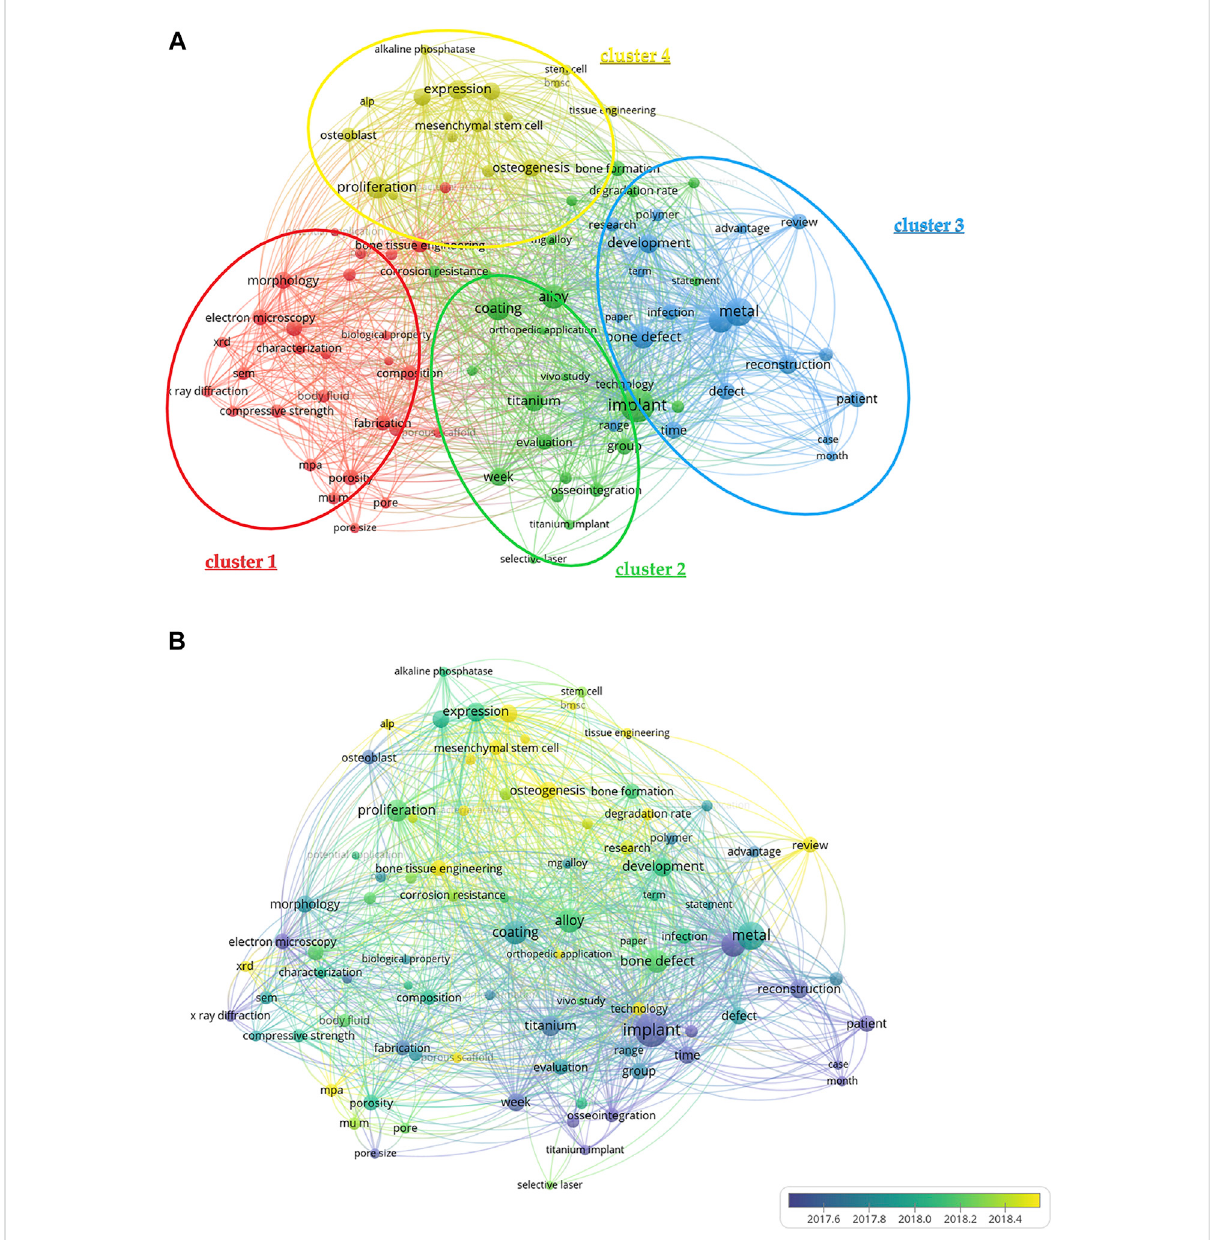
FIGURE 7 Co-occurrenceanalysisofallkeywordsinthepublicationsonmetalmaterialsandbonerepair .(A) Mappingofthekeywordsinthe fi eldofmetal materials and bone repair. The size of the circle represents the frequency of the keyword, and different colors represent different clusters. (B) Distribution of keywords according to the average time of appearance. Blue represents an early appearance, and yellow represents a late